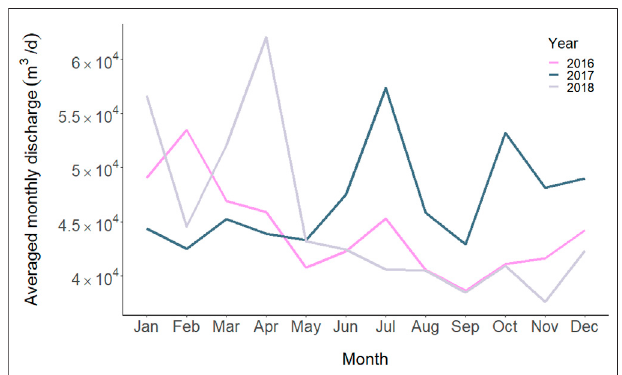
FIGURE 3 | Averaged daily discharge of treated wastewater for the different month at the outlet of the WWTP (data source: Nordwasser